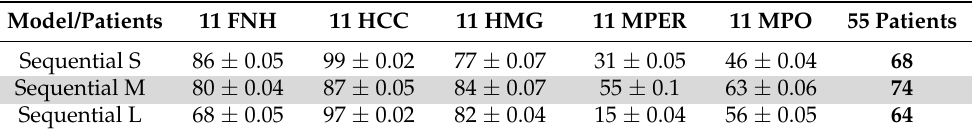
Table 6. Average test accuracy [%] and the corresponding standard deviation. Hard Vote and equal number of examples per class.